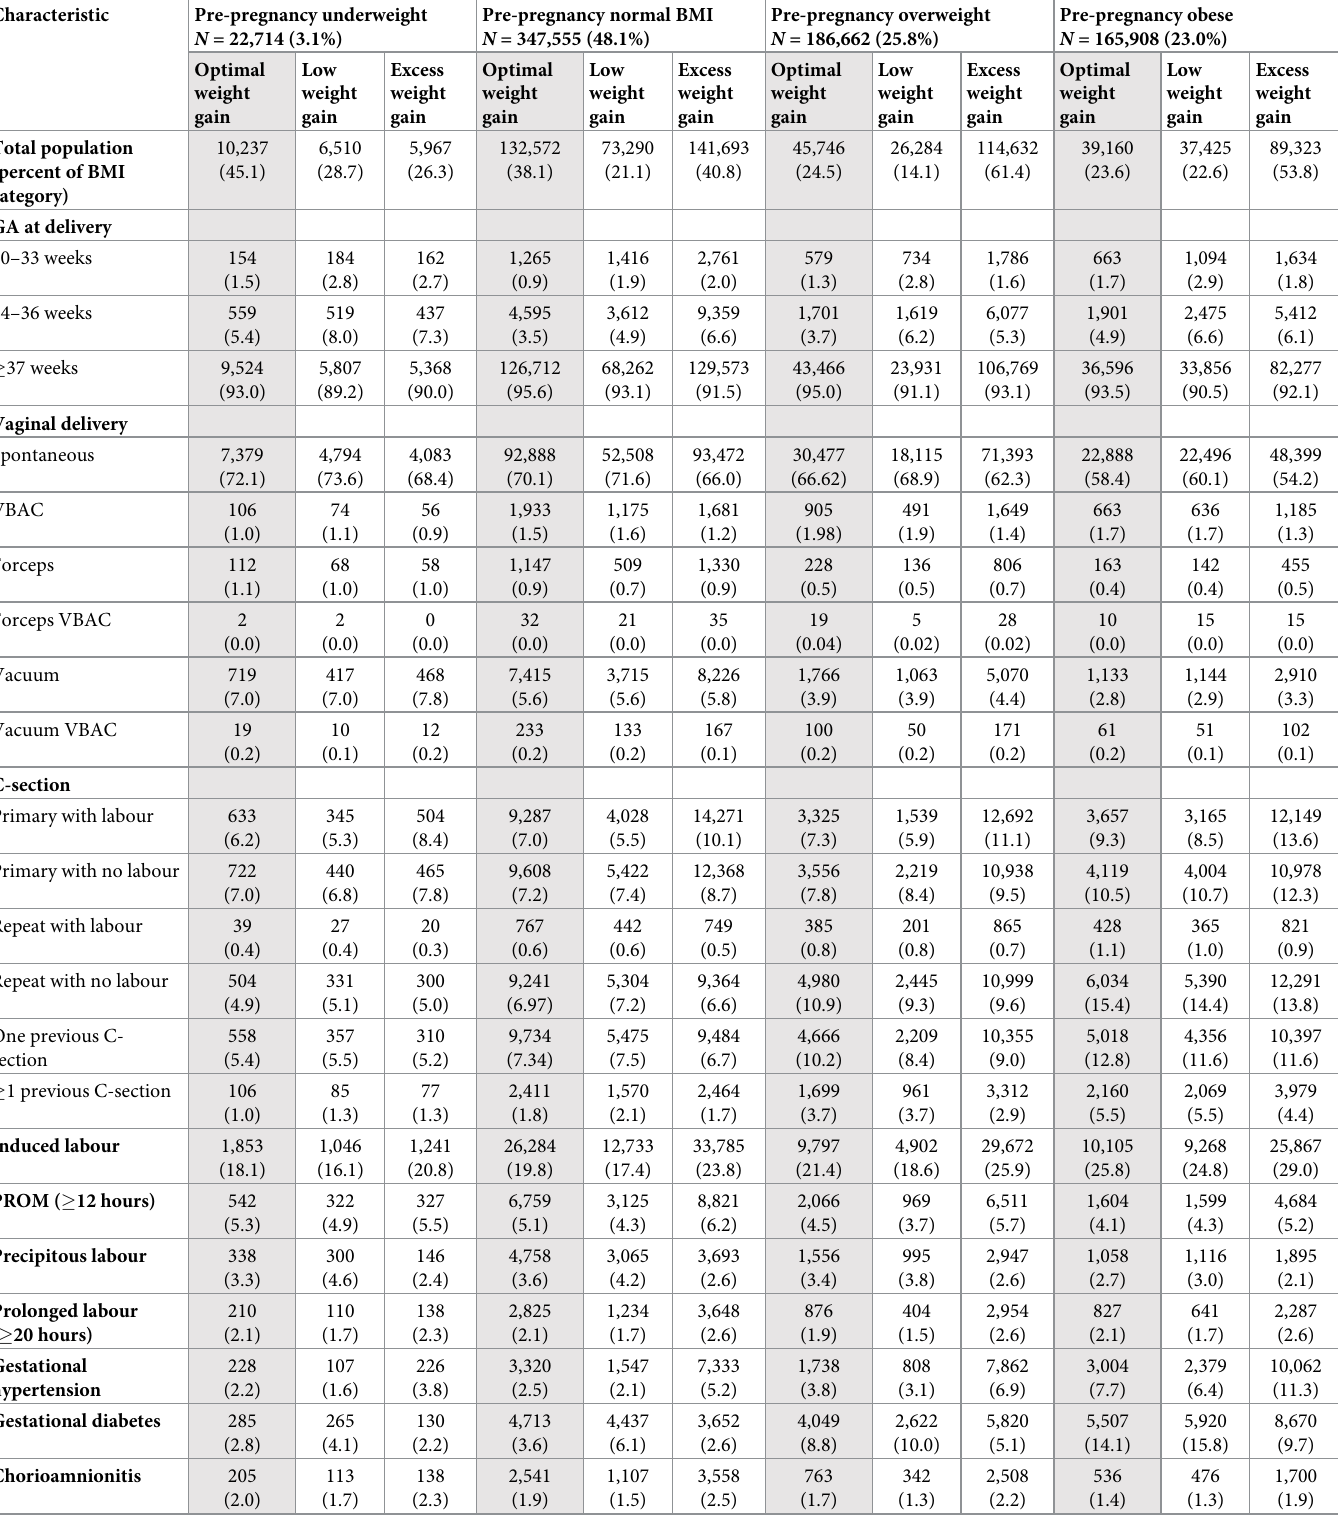
Table 2. Labour and delivery characteristics by pre-pregnancy BMI and gestational weight gain—Singleton births, Washington State, 2004–2013.